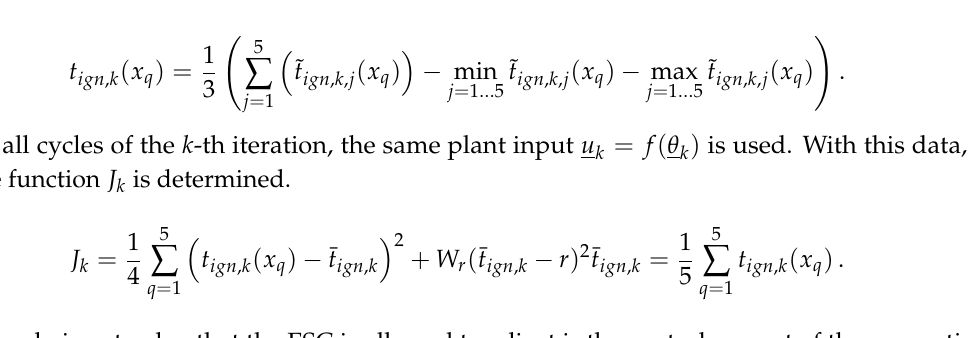
Figure 5. Schematic representation of the ESC used in this paper